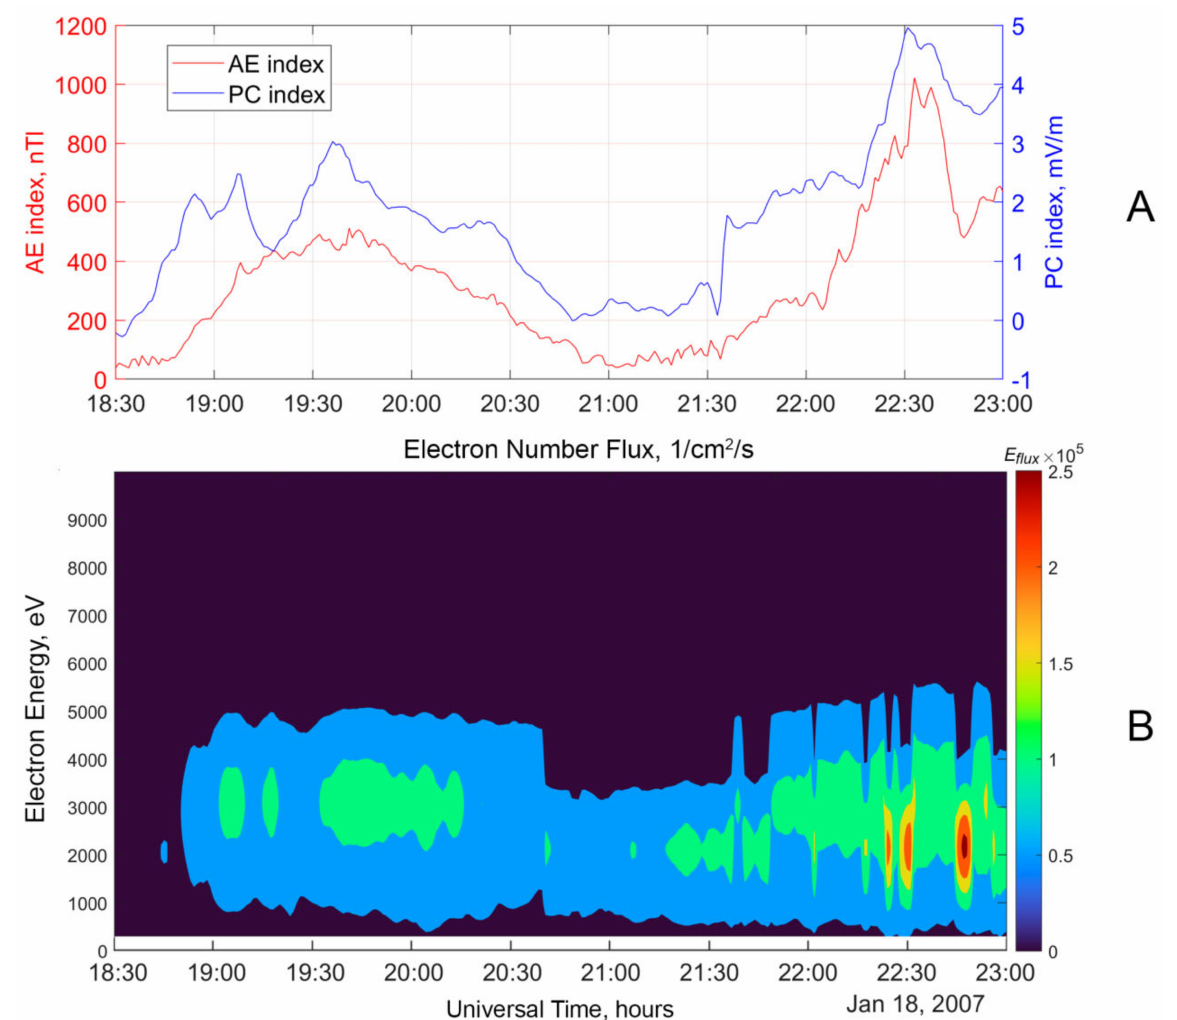
Figure 2. ( A ) Variation of the geomagnetic indices PC in blue and AE in red; ( B ) The electron energy spectrogram for diffuse and monoenergetic electron precipitation (300 eV—10 keV), reconstructed from the OVATION-Prime (PC) output (particle flux and its average energy) for 18 January 2007, 18:30–23:00